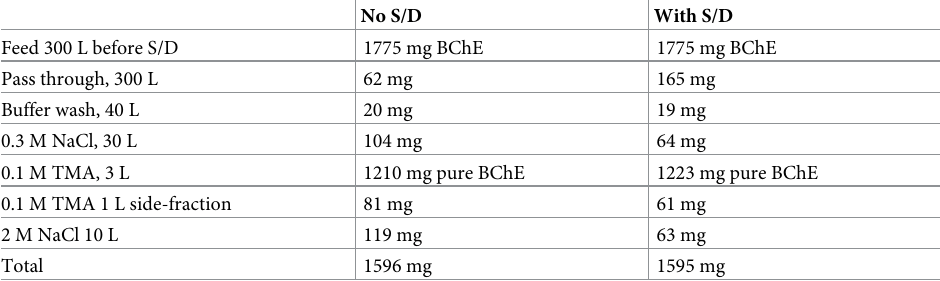
Table 2. Comparison of BChE yield with and without solvent/detergent (S/D) in the Cohn extract. No S/D With S/D Feed 300 L before S/D 1775 mg BChE 1775 mg BChE Pass through, 300 L 62